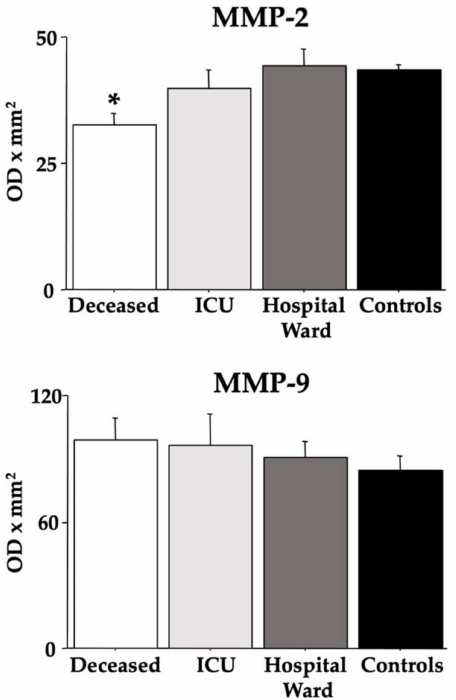
Figure 4. Serum MMP-2 and MMP-9 in COVID-19 patients. The error bars indicate pooled standard error means (SEM) derived from the appropriate error mean square in the ANOVA. The asterisk ( p < 0.05) indicates post hoc differences with